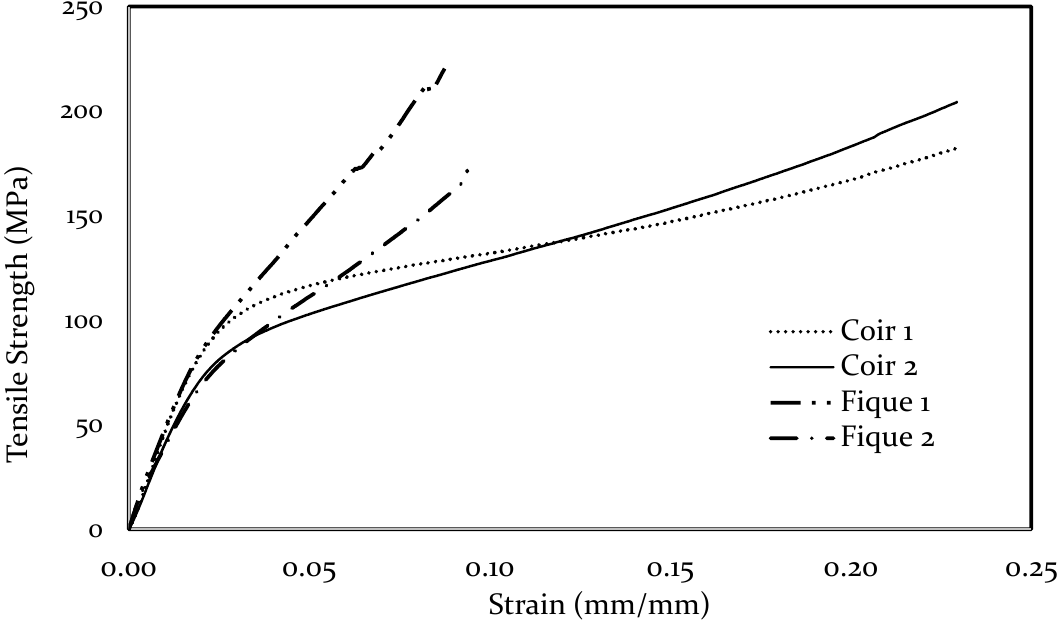
Figure 5. Typical Stress-strain curve of coir and fique.